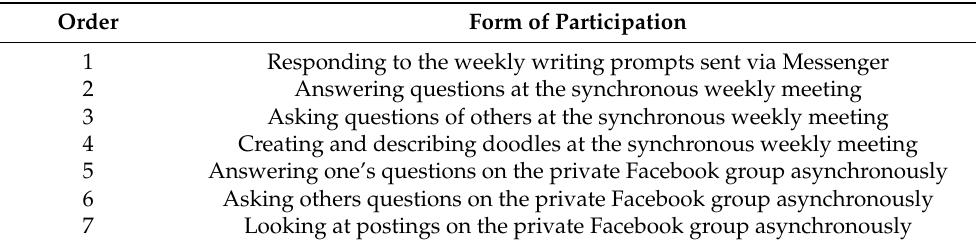
Table 5. Forms of Participation in the Health Narratives Research Group by Order in Which They Would Take Place Weekly during the Academic